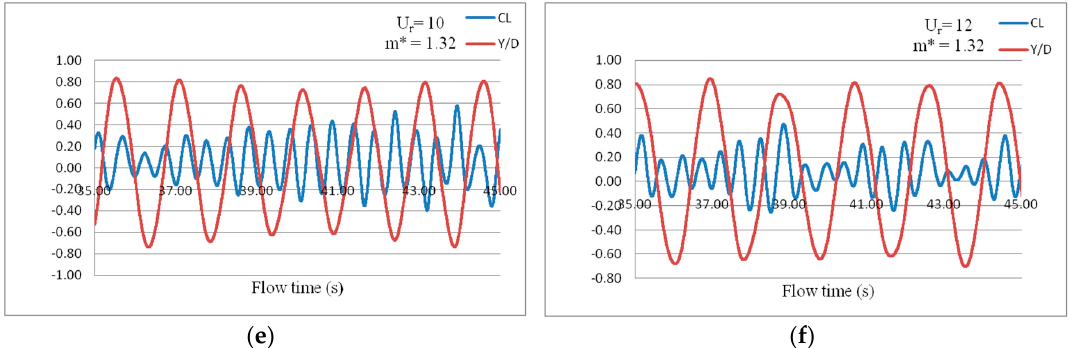
Figure 8. Variation of C L with Y/D for m* = 1.32: ( a ) U r = 4; ( b ) U r = 5; ( c ) U r = 6; ( d ) U r = 8; ( e ) U r = 10; ( f ) U r = 12.